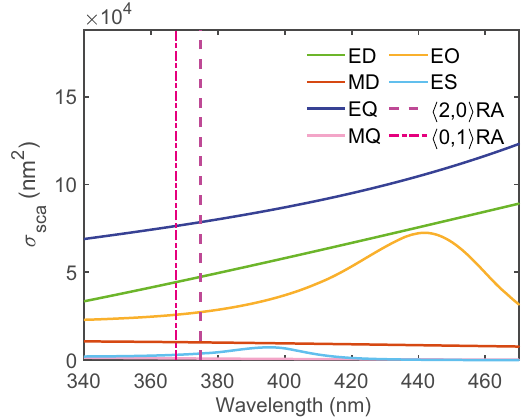
Figure6: (Coloronline)Scatteringcrosssection σ sca calculatedwith Mie theory. EO denotes electric octupole, and ES denotes electric